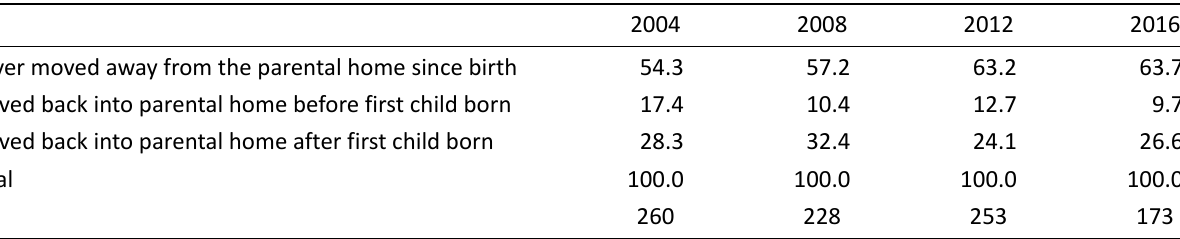
Table 1. Distribution of the middle generation living with their parents, according to how long they had lived in the parental home (in